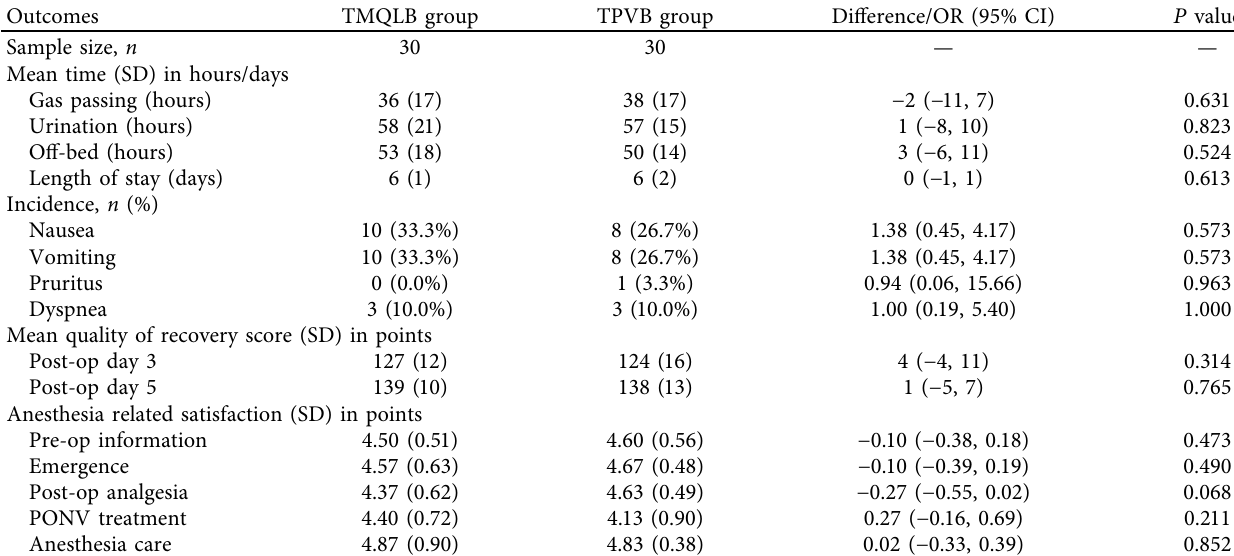
Table 4: Postoperative recovery data of transmuscular quadratus lumborum block and paravertebral block